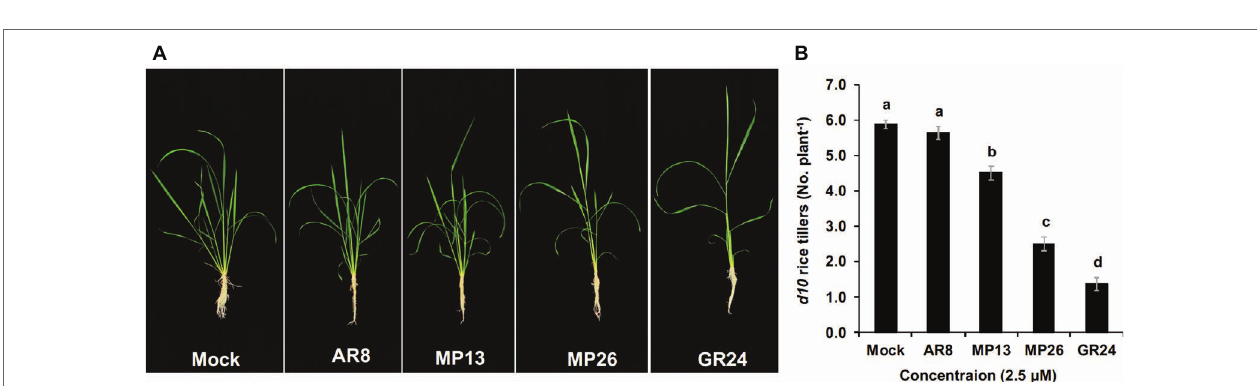
FIGURE 3 | (A) Tillering phenotype of d10 mutant in response to SL analogs’ application. (B) Effect of SL analogs on tillering inhibition. The SL analogs were applied